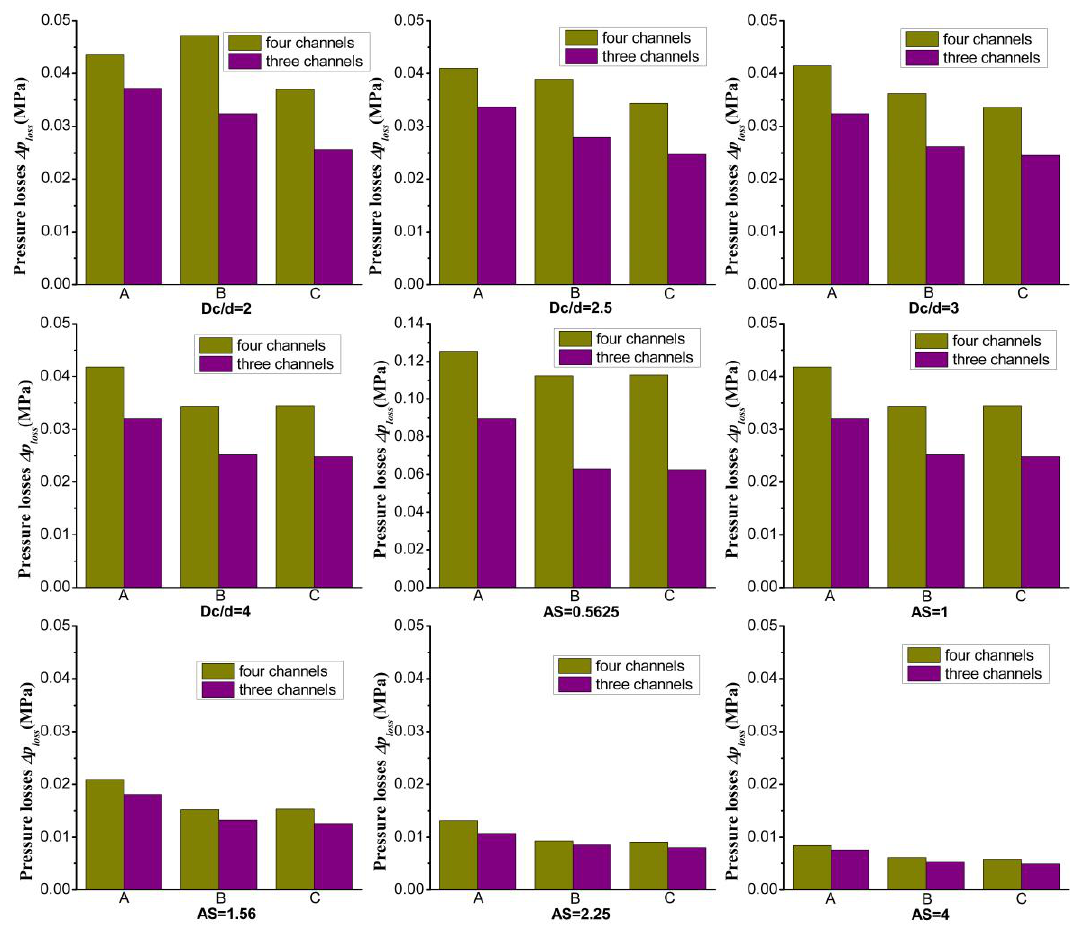
Figure 15. Influence of number of channels on the total pressure loss. Table 7. Pressure losses of “A” “B” and “C” configurations with different channel combinations under three parallel channel operations.